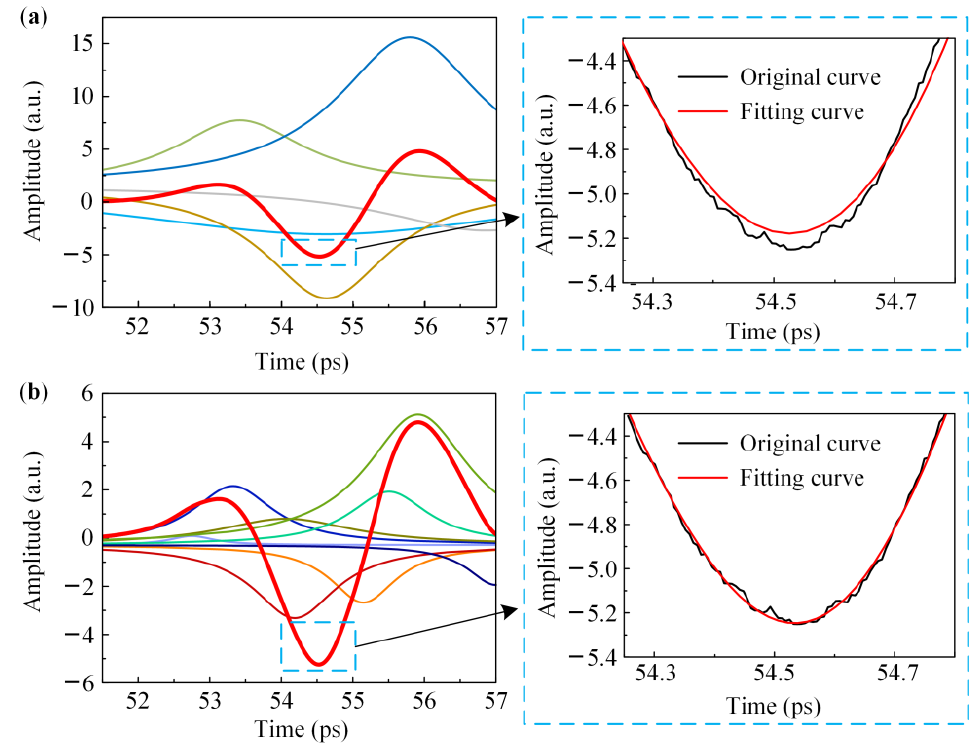
Figure 7. Result of multimodal fitting for terahertz time-domain spectroscopy with the comparison with original curve: ( a ) the number of sub-peaks is 5; ( b ) the number of sub-peaks is 10.